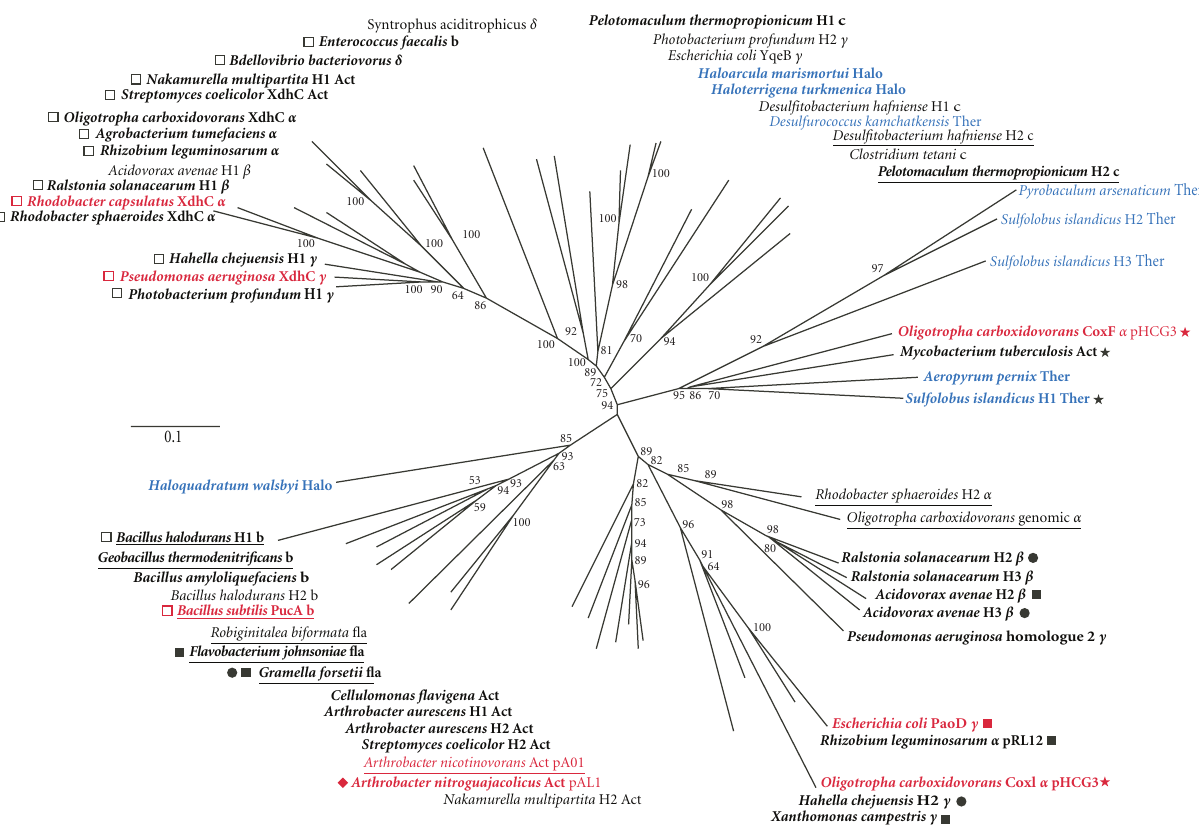
Figure 5: Phylogenetic tree of XdhC homologues. Protein phylogeny of XdhC homologues based on a full length sequence alignment. The tree was constructed by the neighbor-joining method from a matrix of estimated numbers of amino acid substitutions per site calculated with the Dayho ff option of Phylip. Numbers near branches indicate the bootstrap proportion for 100 replicas using the same method. The scale bar indicates 0.1 substitutions per site. Bacterial XdhC homologues from (partially) characterized operons are marked in red, XdhC homologues from Archaea are marked in blue, and in case several XdhC homologues present in one genome, they are marked by H1, H2, H3; class: b: Bacilli; c: Clostridia; α : Alphaproteobacteria; β : Betaproteobacteria; γ : Gammaproteobacteria; δ : Deltaproteobacteria; Act: Actinobacteria; fla: Flavobacteria; Halo: Halobacteria; Ther: Thermoprotei. Underlined XdhC homologues are part of an operon encoding Moco biosynthesis proteins, XdhC homologues in bold are part of an operon encoding a molybdoenzyme, putative molybdoenzyme partners were annotated based on a full length sequence alignment of the Moco binding subunit and by comparison of active site amino acids: PaoC homologues (filled square), XOR homologues (open square), CoxL/CutL homologues (filled star), isoquinoline 1-oxidoreductase homologues (filled circle) and quinaldine 4-oxidase (filled